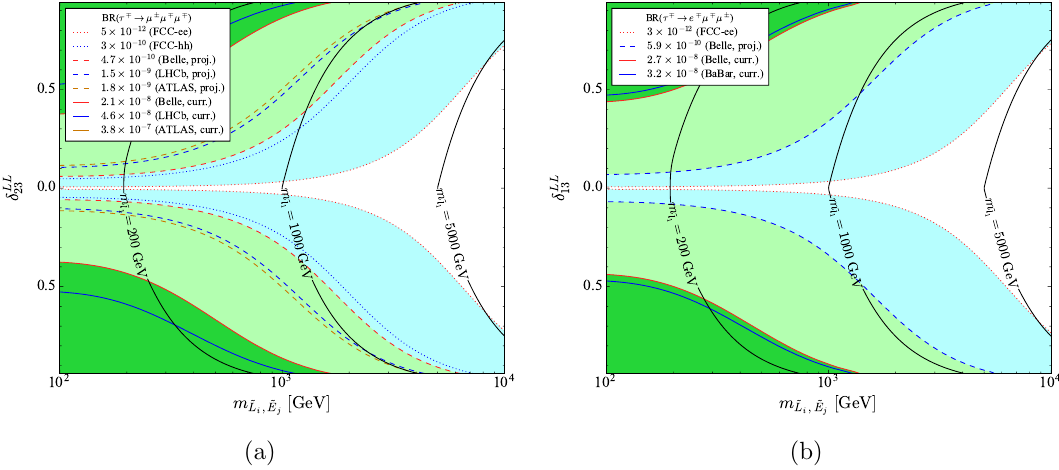
LL ~ L i ; ~ E j and (cid:14) 23